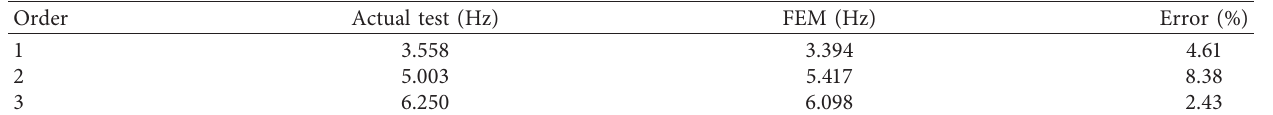
Table 5: The evaluation of the two